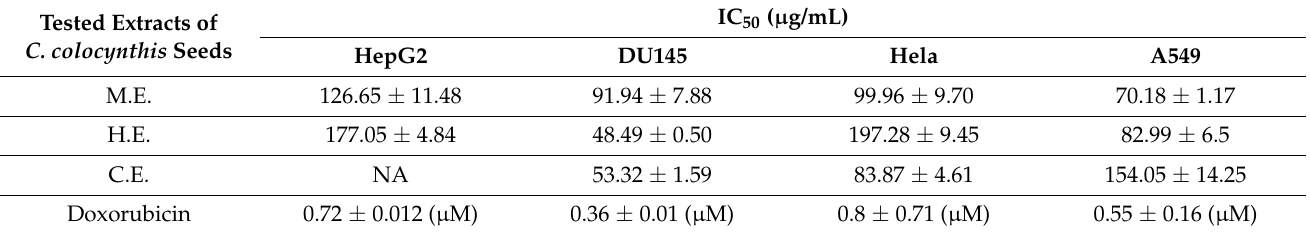
Table 4. Anticancer activity of various extracts of C. colocynthis seeds against various cancer cell lines. Tested Extracts